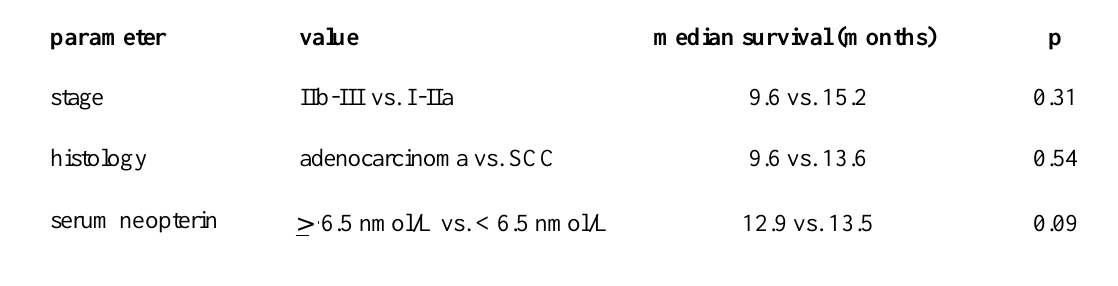
Table 2. Univariate analysis of prognostic parameters in patients without distant metastases. SCC squamous cell